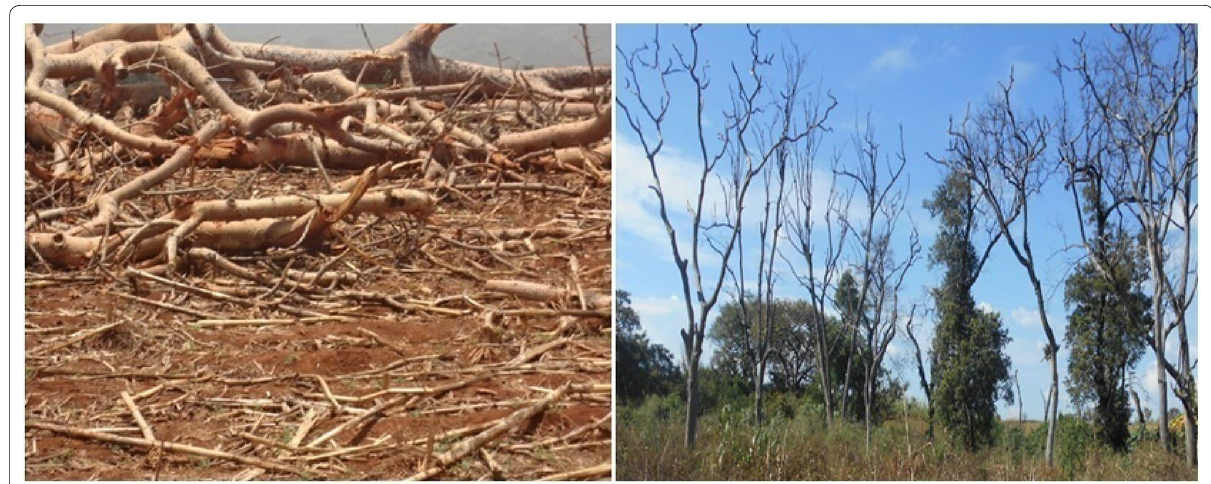
Fig. 7 Vegetation resource destruction in Chewaka district, field photo (2018)